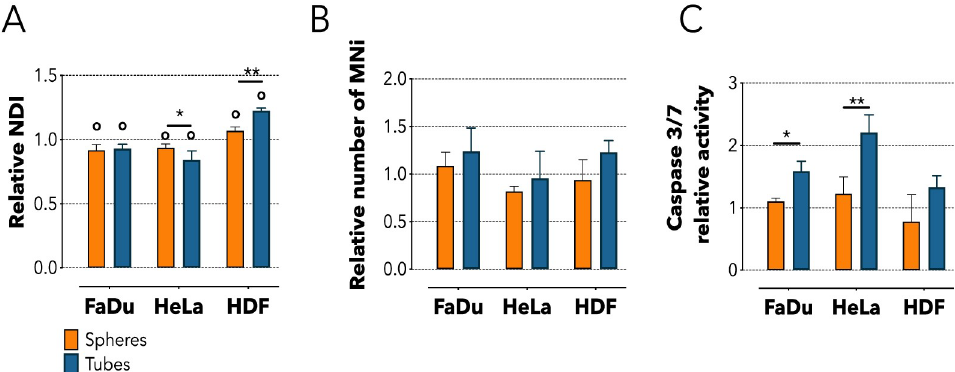
Fig 3. Cellular metabolic effects following spheres or tubes internalization. (A) Nuclear Division Index (NDI) quantification for FaDu, HeLa and HDF cells after 24 hours incubation with spheres or tubes. (B) Micronucleus assay (MNi) for addressing the presence of DNA damage after 24 hours incubation with spheres or tubes. (C) Caspase 3/7 assay for analyzing the activation of extrinsic apoptosis following 24 hours incubation with spheres or tubes. Two-way ANOVA. � = p < 0.05, �� = p < 0.01, o = statically different compared to the untreated control. n = 3 independent experiments.